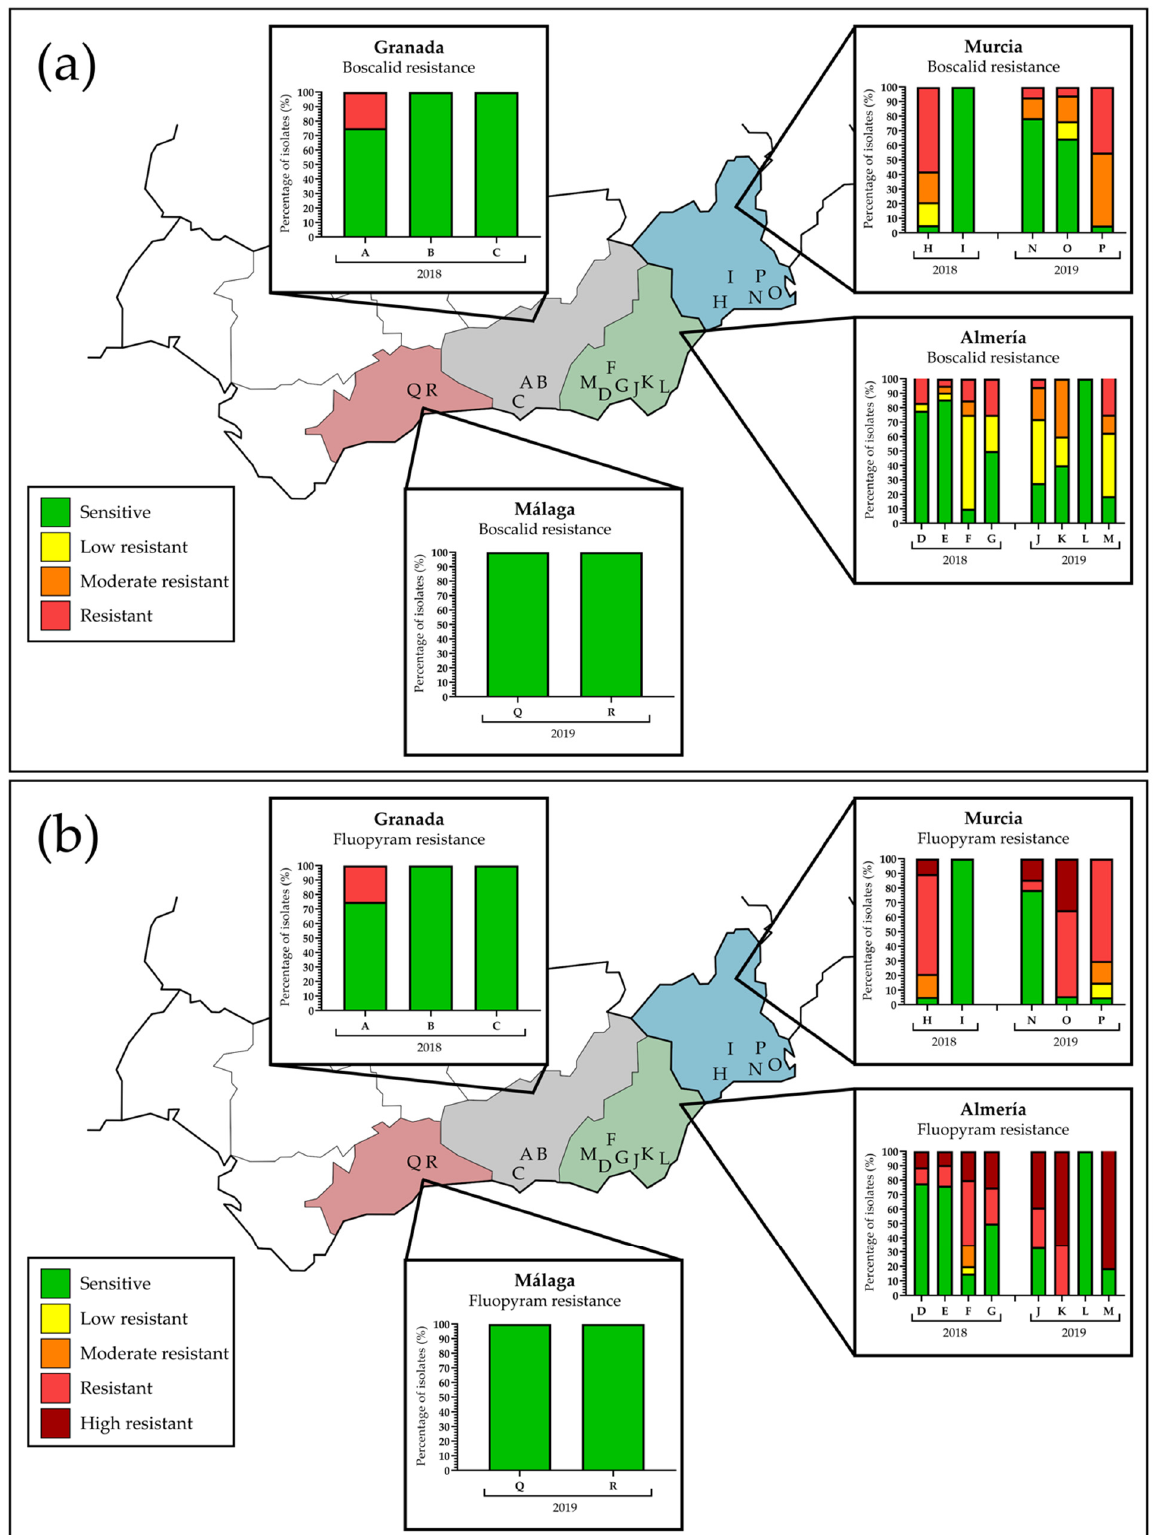
Figure 1. Percentage and phenotype of SDHI isolates detected in the SDHI field monitoring studies: ( a ) percentage of boscalid-sensitive and boscalid-resistant isolates in provinces of Almeria (eight localizations), Granada (three localizations), Malaga (two localizations) and Murcia (five localizations) during 2018–2019 seasons; ( b ) percentage of fluopyram-sensitive and fluopyram-resistant isolates in the same provinces and years.